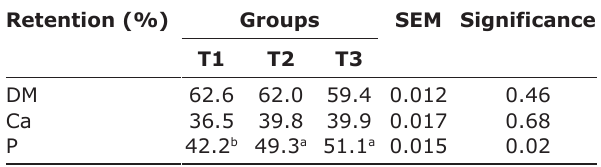
Table-4: Influence of dietary treatments on the retention (%) of dietary minerals. Retention (%) Groups